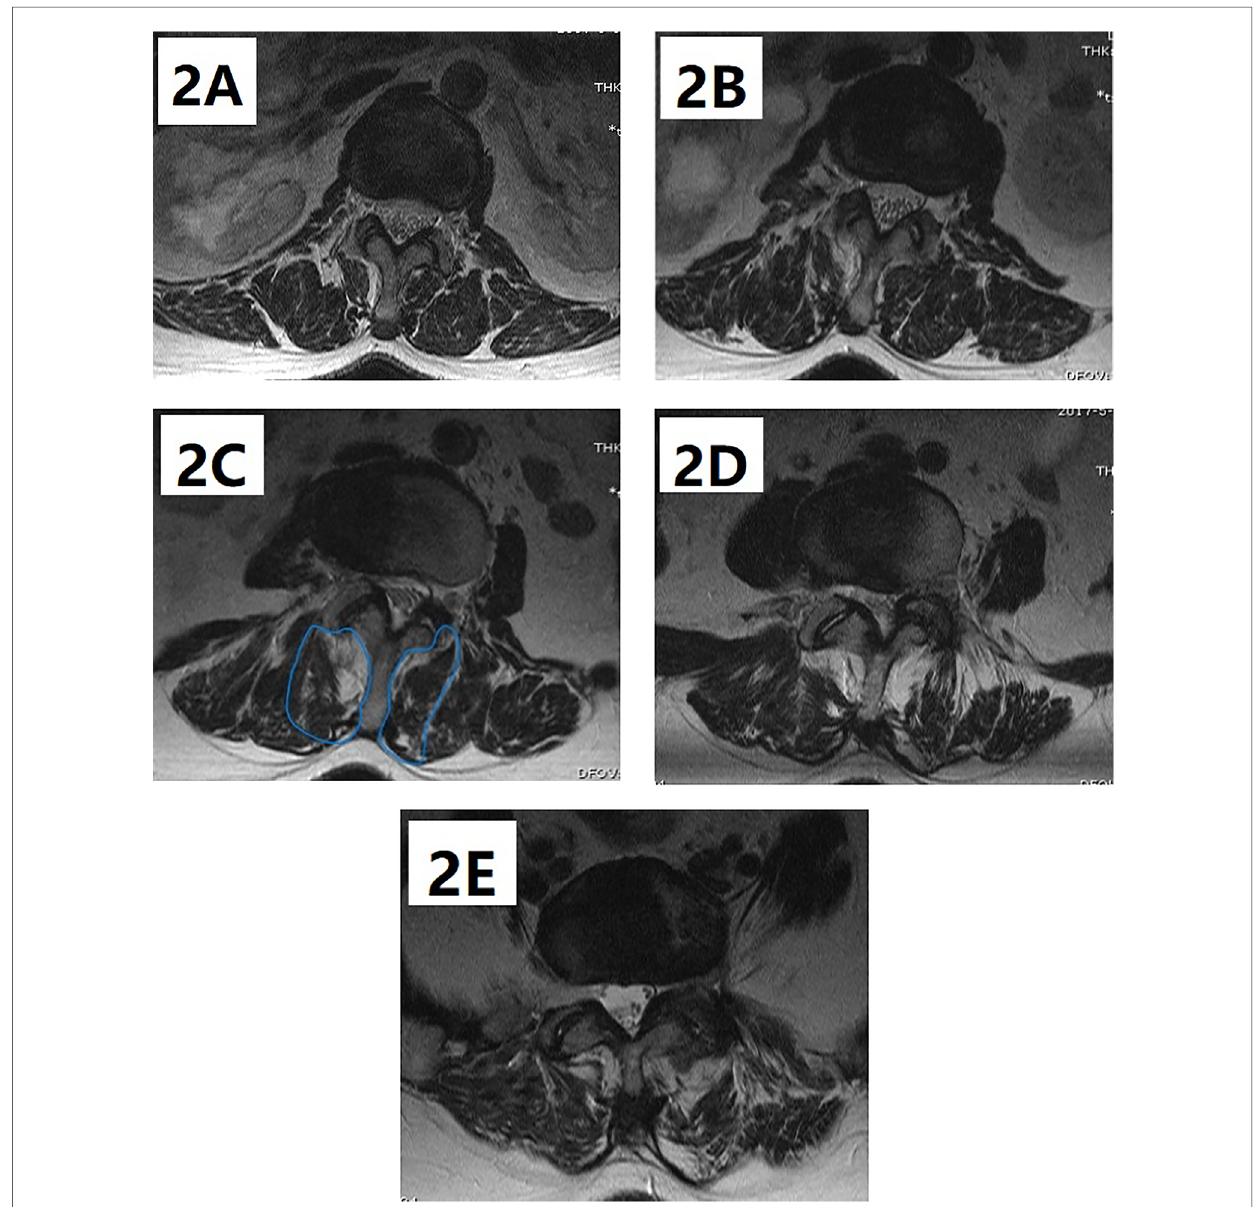
FIGURE 2 ( A – E ) Fat tissue on the MRI is colored in white; FIA% of the multi fi dus muscle on the convex side is 27.09%, 14.26%, 30.37%, 33.36%, and 30.69%, and on the concave side, it is 40.67%, 42.77%, 39.25%, 34.16%, and 43.02% at the L1-2, L2-3, L3-4, L4-5, and L5-S1 levels, respectively; the asymmetric degree of the multi fi dus muscle is 12.82% and the average degree of the multi fi dus muscle is